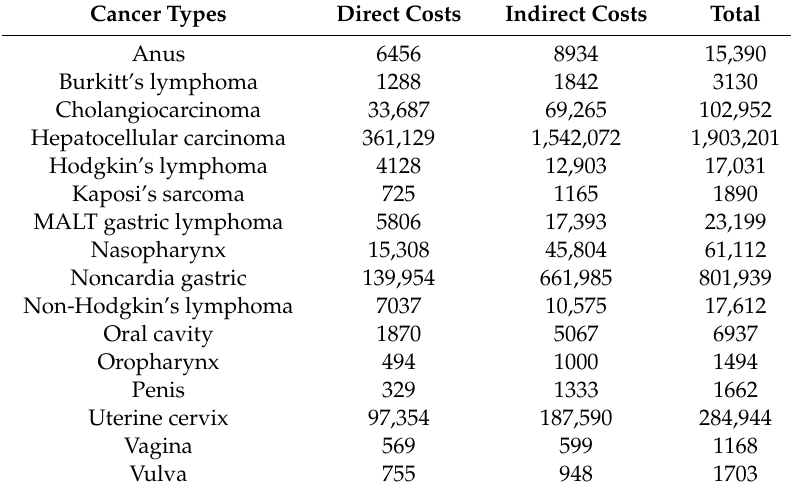
Abbreviations. MALT, mucosa-associated lymphoid